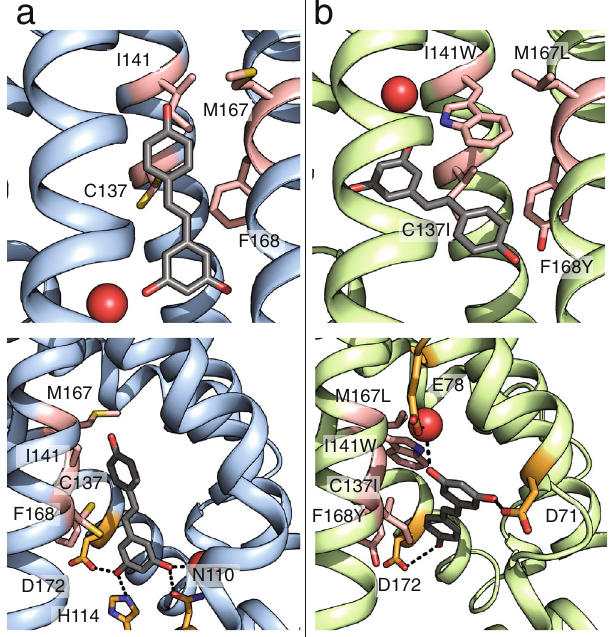
Fig. 4 Structural basis for ligand speci fi city. Wild-type TtgR and quadruple mutant are shown in blue and green ribbons, respectively. Positions 137, 141, 167, and 168 are colored in pink. Resveratrol is shown as gray sticks. Water molecules are shown as red spheres. a Binding pocket of resveratrol-bound wild-type TtgR (PDB ID: 7K1C) (upper panel) with residues making hydrogen bonds to resveratrol highlighted in orange (lower panel). b Binding pocket of resveratrol-bound quadruple mutant TtgR (PDB ID: 7KD8) (upper panel) with residues making hydrogen bonds to resveratrol highlighted in orange (lower